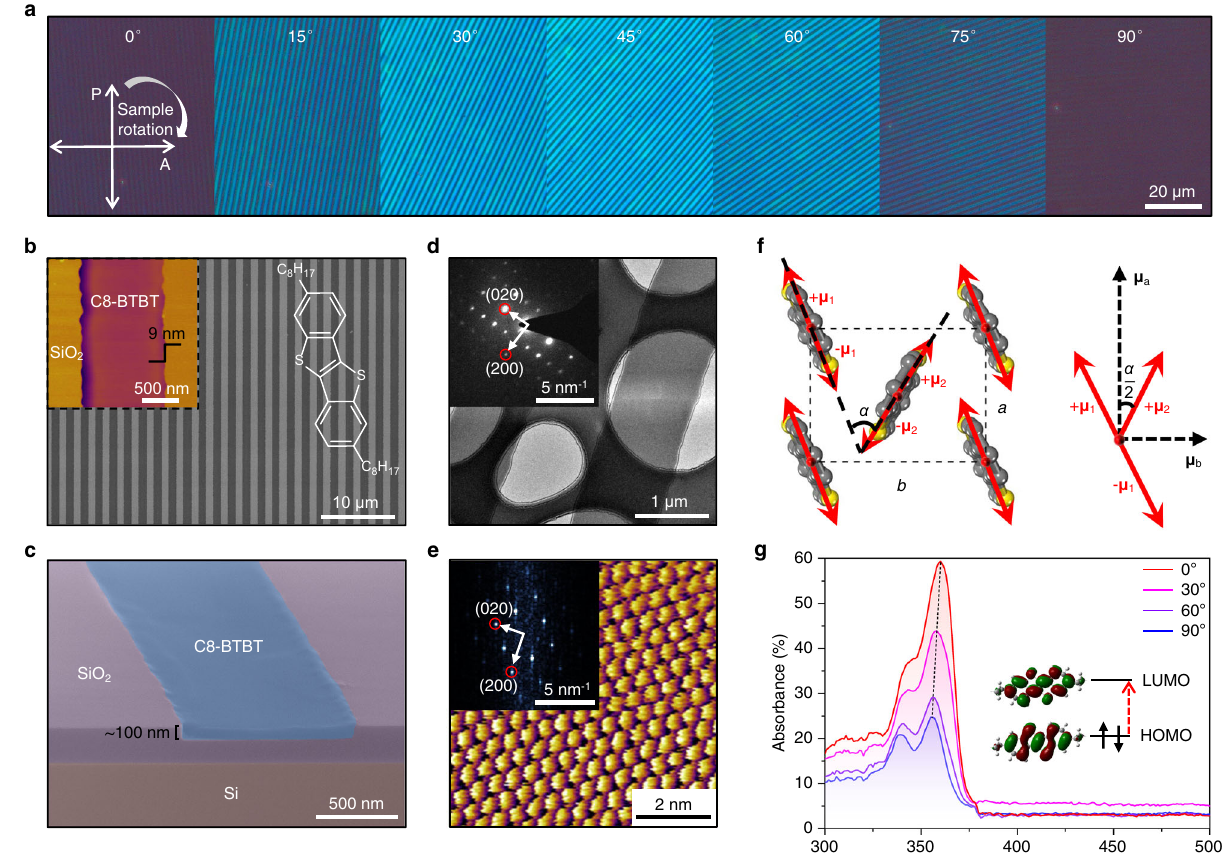
Fig. 2 | Morphological characterizations and optical anisotropy of C8-BTBT crystals.a Angle-resolvedCPOMimagesoftheC8-BTBTcrystalarray. b SEMimage of the C8-BTBT crystal array. The darker ribbons indicate the C8-BTBT crystals while the brighter regions represent SiO 2 surface. The right inset shows the structure of a C8-BTBT molecule, and the left inset is an AFM image of a C8-BTBT crystal inside the SiO 2 channel. c Colored cross-sectional SEM image of a C8-BTBT crystal inside the SiO 2 channel in a 5° oblique view. d TEM image of a C8-BTBT crystal. The inset SAED pattern clearly reveals the diffraction spots of ( l 00) and